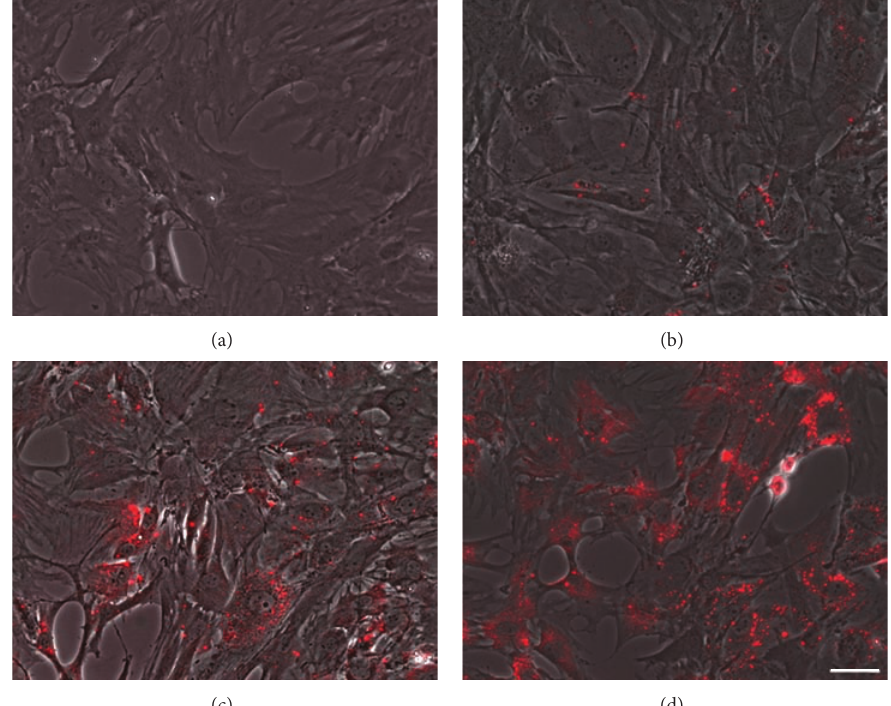
Figure 1: Fluorescence intensity and distribution of QD treated living stem cells 24 h after labeling. (a) Control without QDs, (b) 5 nM QDs, (c) 10nM QDs, and (d) 20 nM QDs. Scale bar represents 50 𝜇 m.